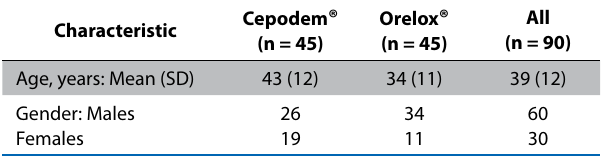
Table II. Summary of demographics